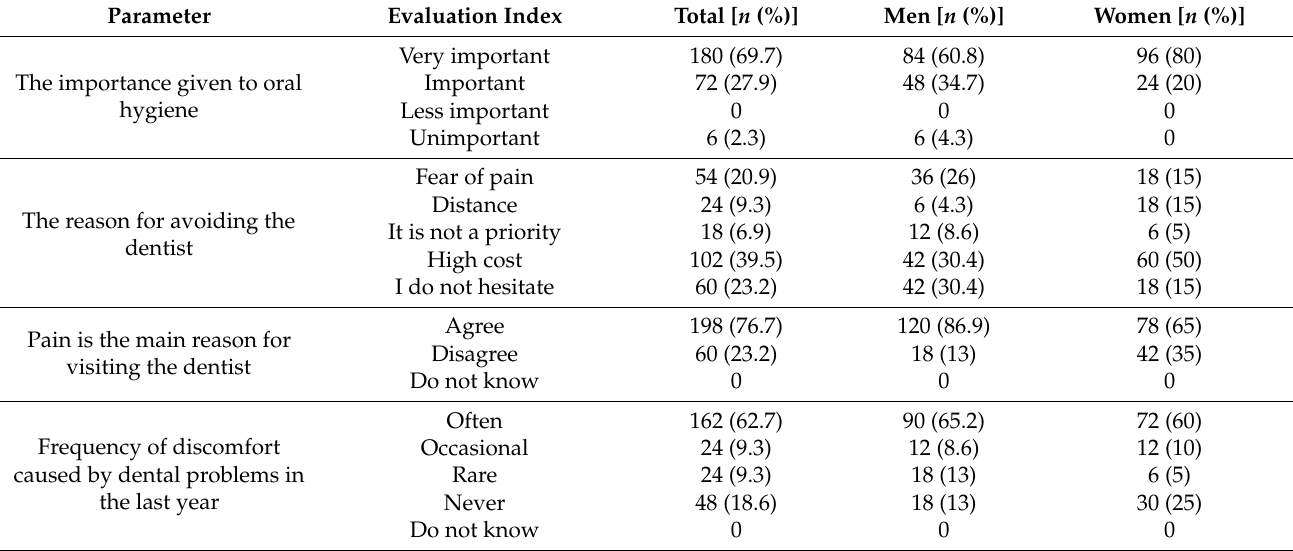
Table 3. Patients’ attitudes towards oral